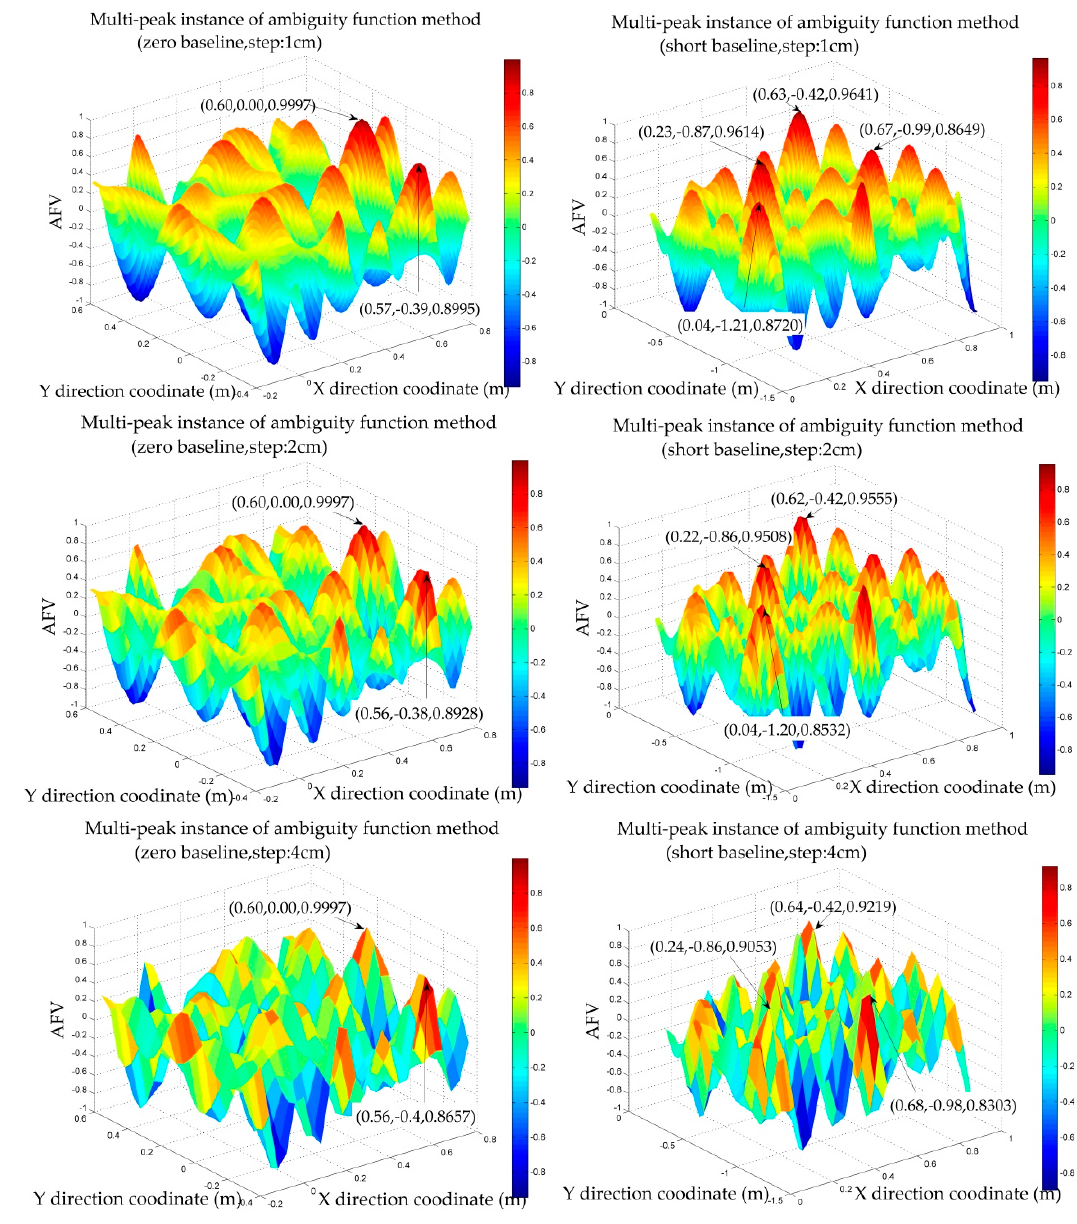
Figure 7. The effect of AFM step length on multi-peaks.